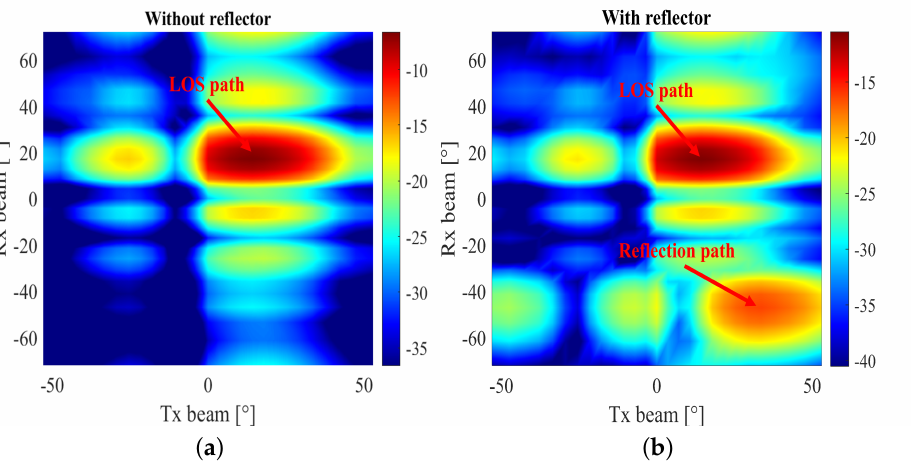
Figure 14. ( a ) Without the metal plate and ( b ) with the metal plate results of the channel sounding. The power angle delay profile (PADP) obtained by the channel sounder for the channel without and with the metal plate when the Tx steering a beam to direction 17.9° is